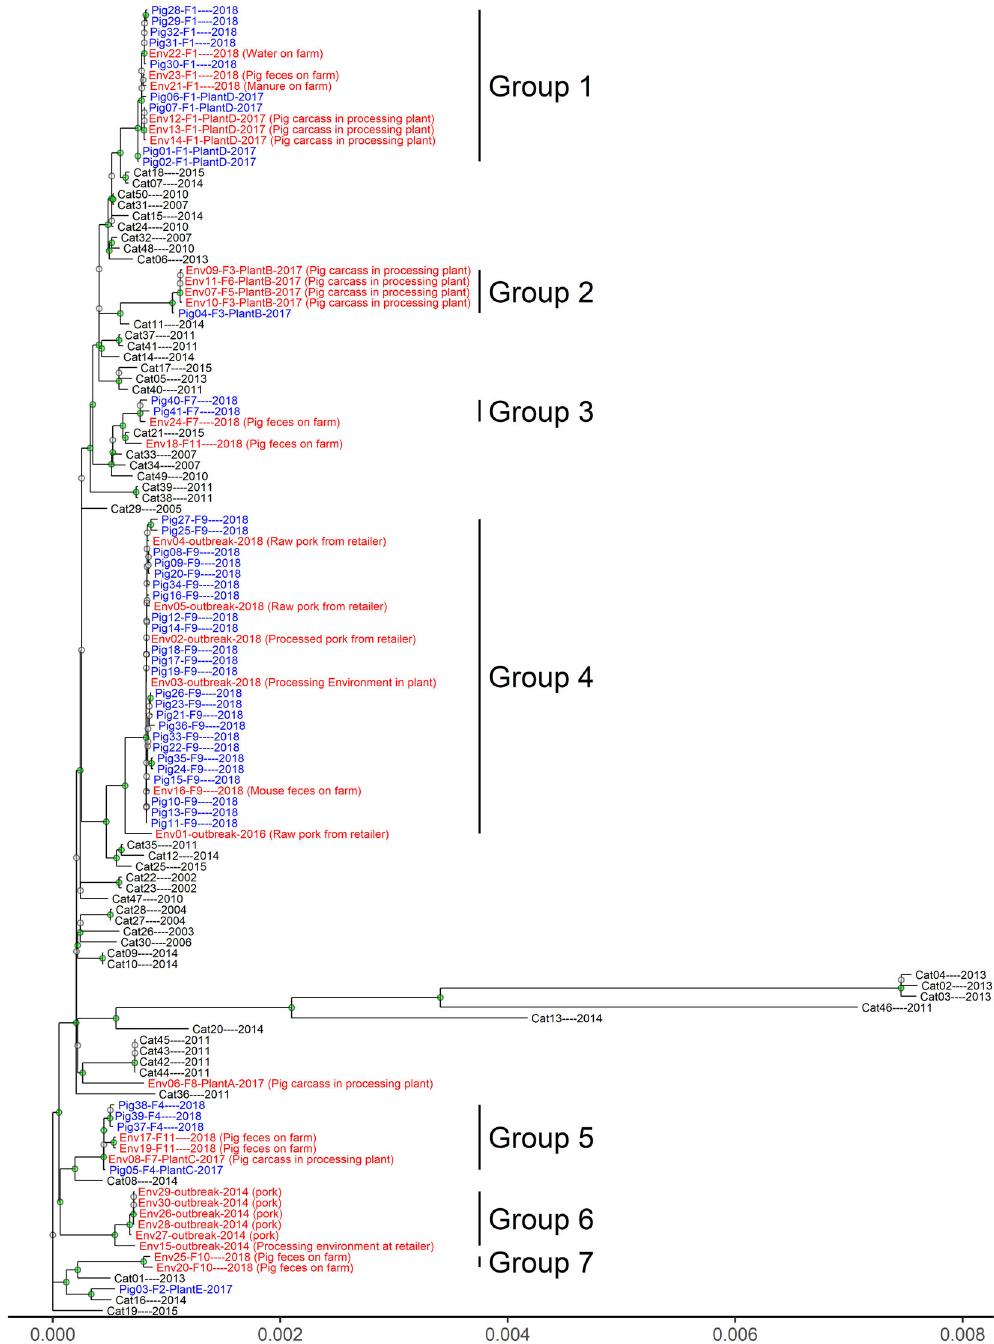
Fig. 3 A maximum likelihood tree based on core SNPs of EDL933 (Reference) and 121 E. coli O157:H7 isolates from pigs, cattle and pork production environment. The nodes with bootstrap support value >70 are labeled green. The substitution(s) per site is represented in the scale bar. Each tip in the tree was labeled with the isolate ’ s identi fi cation and, if applicable, its associated farm (F), and/or processing plant (Plant) followed by the year of collection. The pig isolates (blue) and cattle (black) isolates were recovered from fresh fecal/cecal samples of both animal species. The environment isolates (red) were recovered from various samples (information added in the parenthesis following the tree tips) collected from the pork production and distribution chain. Porcine and environmental isolates primarily clustered in seven groups in the tree, as labeled in the fi